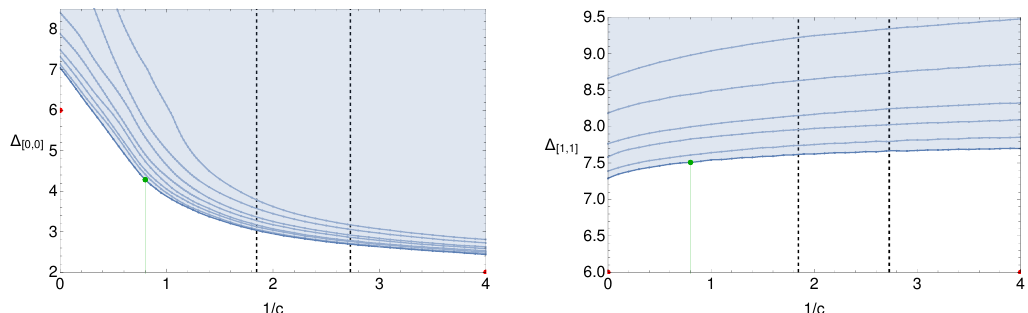
Figure 5 . Upper bound on the dimensions of long multiplets A (cid:1) > 2 for di(cid:11)erent values of the inverse of the central charge c . The maximum number of derivatives is (cid:3) = 24, and the weaker bounds correspond to decreasing the number of derivatives by two. The red dots mark the dimension of the (cid:12)rst long operators for generalized free (cid:12)eld theory and U(1) N = 4 SYM, while the green line marks the central charge c = 15 with the green dot providing an upper bound for this theory. The two dashed lines correspond to the minimum central charges for an interacting N = 2 [47] and N = 3 SCFTs [75].